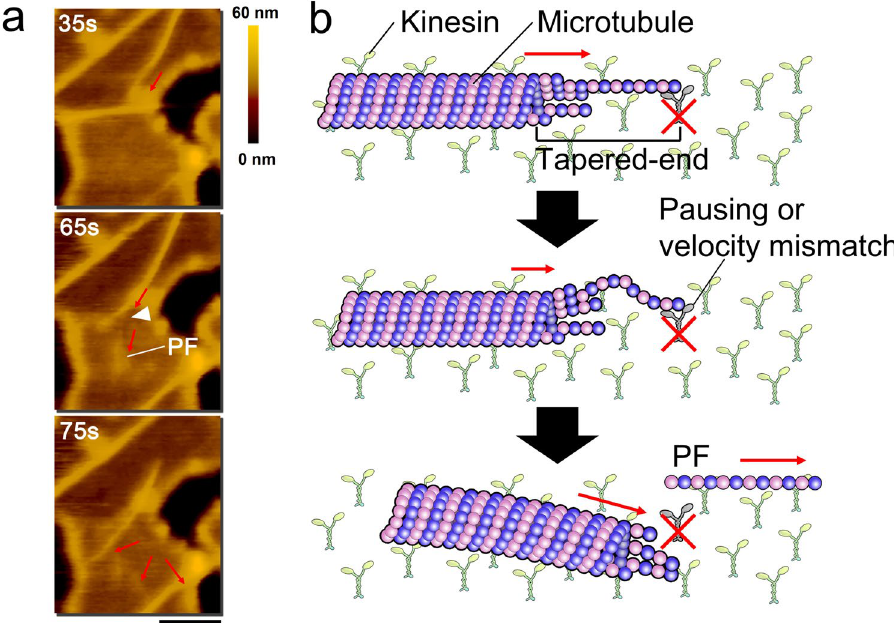
Figure 4. Sudden change in direction of gliding MTs with segregation of tapered PFs from the leading end. ( a ) Time-lapse images showing splitting of a MT at the tapered leading end during gliding motion. The red arrows show moving direction of gliding MTs and PFs separated from leading end of the MT. Scale bar: 500 nm and frame rate: 0.2 s/frame. ( b ) Schematic model showing sudden directional change of MT with segregation of a PF from the tapered leading end of the